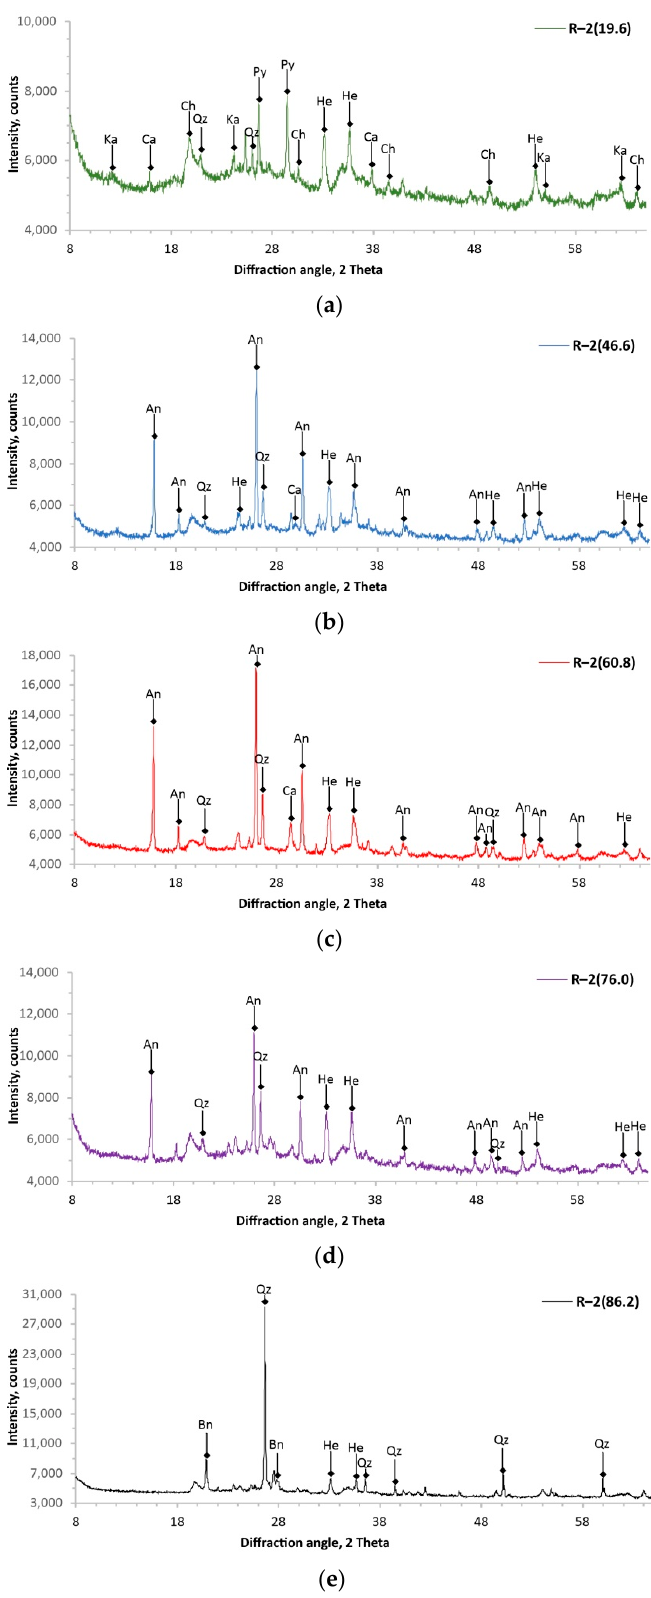
Figure 6. The X-ray patterns of core samples from Radoshivka–2 well: R–2(19.6) ( a ); R–2(46.6) ( b ); R–2(60.8) ( c ); R–2(76.0) ( d ); R–2(86.2) ( e ). Ch, chlorite; An, analcime; Qz, quartz; Ka, kaolinite; Py, pyroxene; He, hematite; Ca, calcite. Table 6. Mineral composition of volcanic tuff core samples from Radoshivka–2 well (% w / w ).